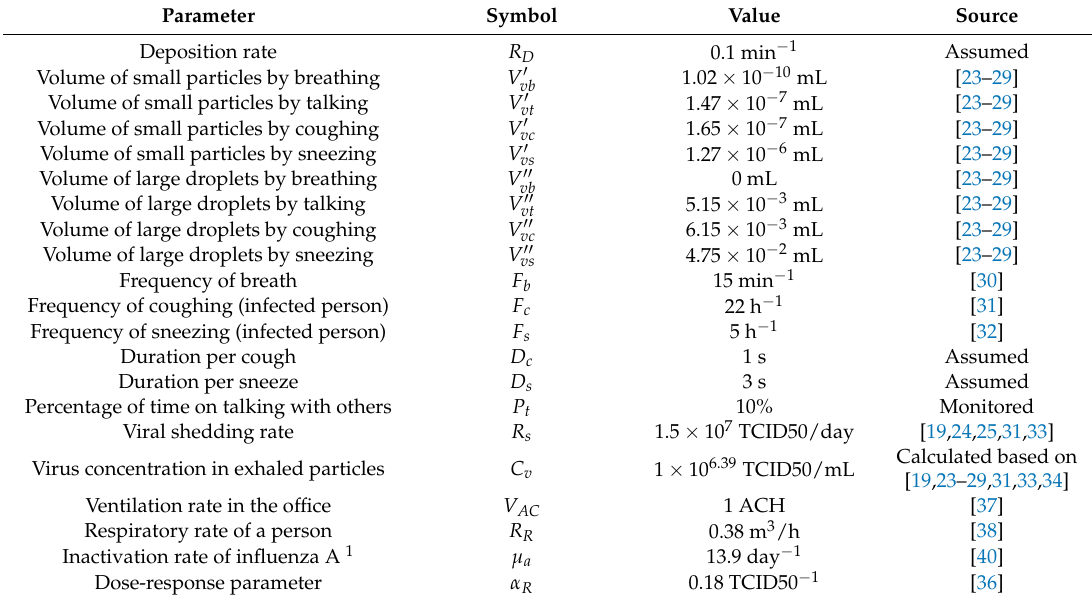
Table 2. Parameters related to long-range